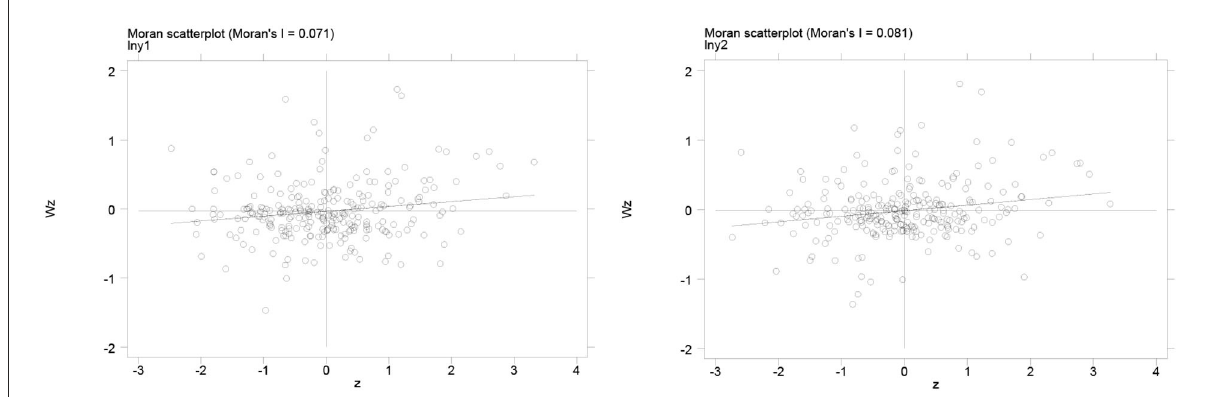
FIGURE4 Moran scatterplot of health care environment in 2019. The left graph denotes the Moran scatterplot of medical workforce (ln mw ) and the right graph denotes the Moran scatterplot of medical infrastructure (ln mi ).